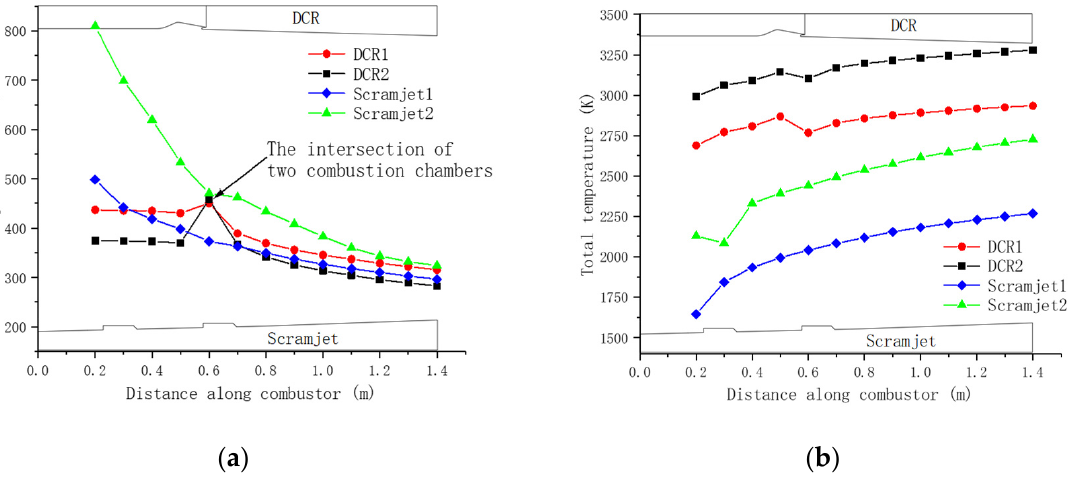
Figure 14. Curves for ( a ) total pressure and ( b ) total temperature.